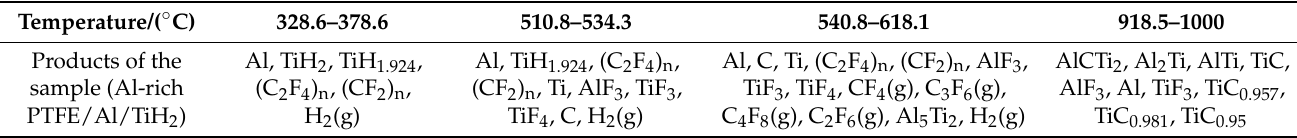
Table 20. The products of Al-rich Al/PTFE/TiH 2 composites in different temperature ranges under argon atmosphere. Temperature/( ◦